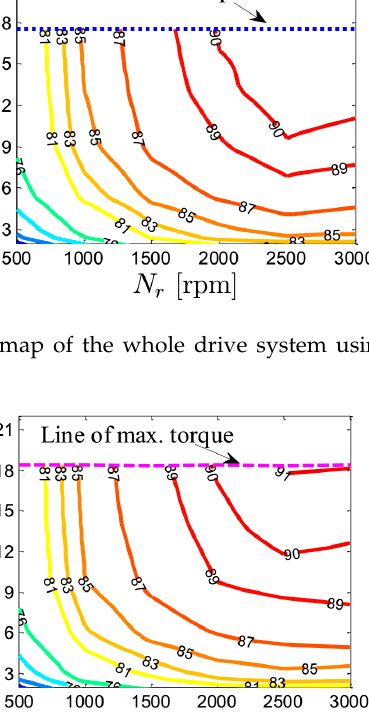
Figure 28. Measured efficiency map of the whole drive system using the Sd machine at optimal current angles.